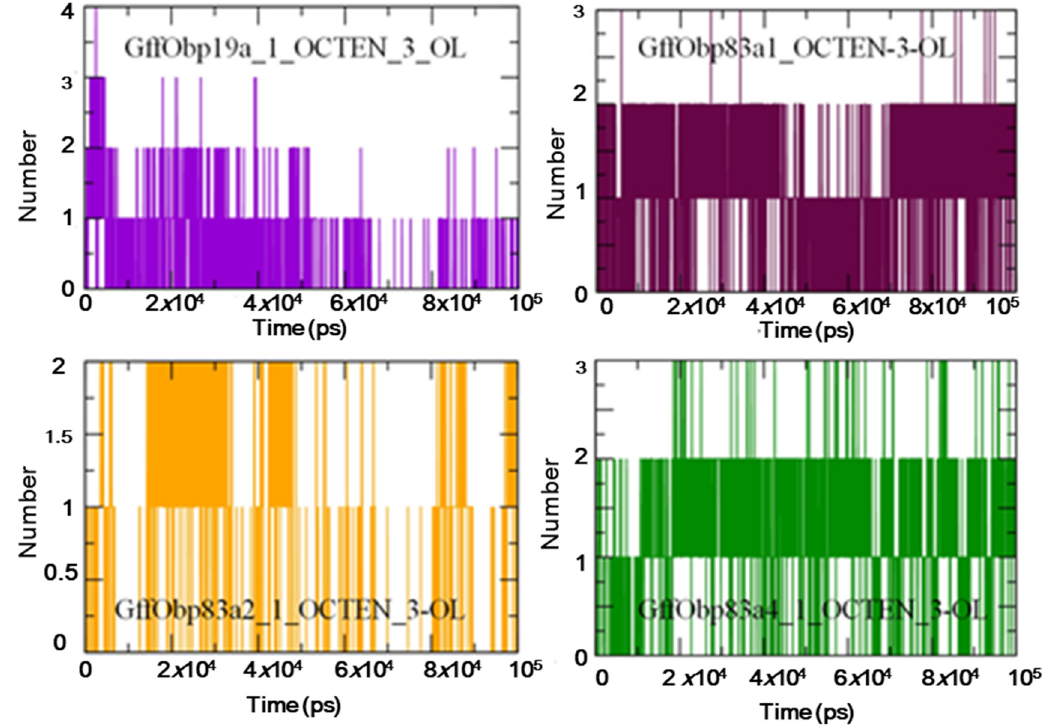
Figure 5. Graphs illustrating the variations observed in the pattern of hydrogen bonding between the studied proteins and ligands during 100 ns molecular dynamics (MD) simulations.